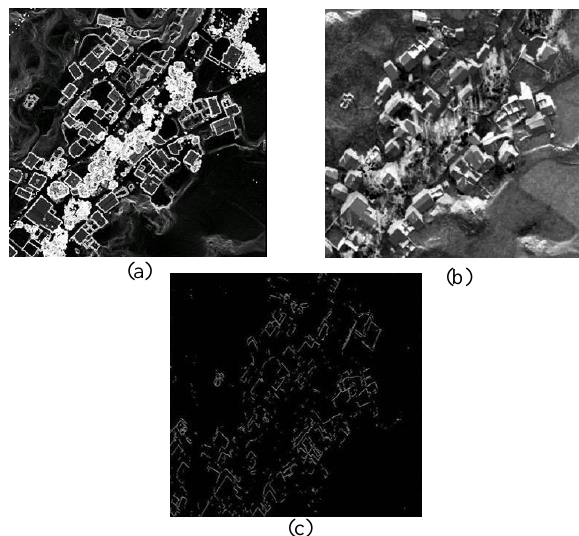
Figure 3. The slope image (a), band subtraction image (b) and canny image(c) of study area